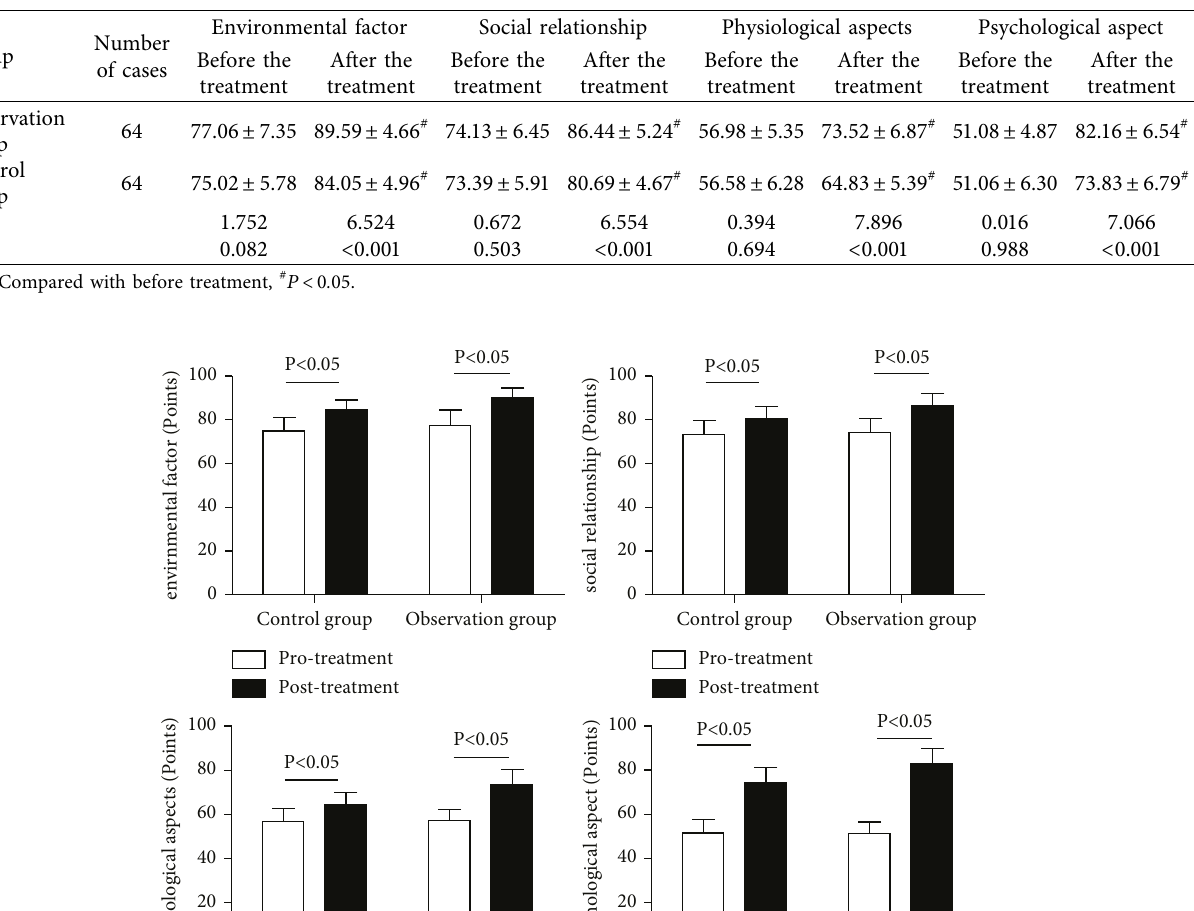
Figure 3: Comparison of medication compliance between the two groups. Table 4: Comparison of quality of life between the two groups ( x ± s , points).